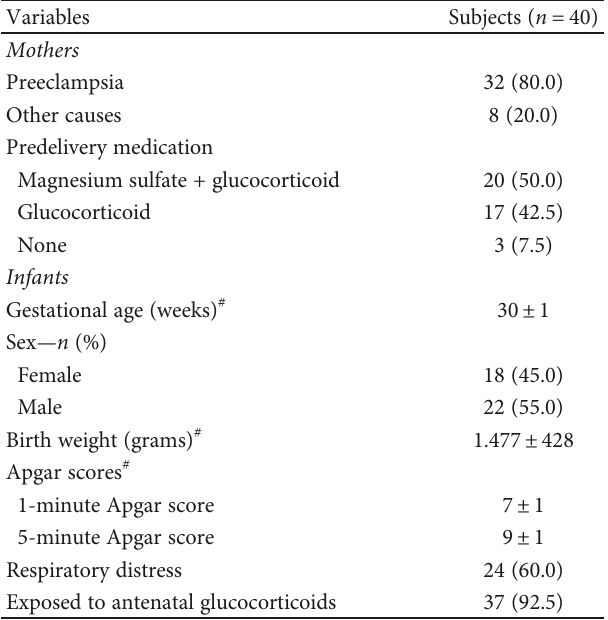
Table 1: Mother and infant